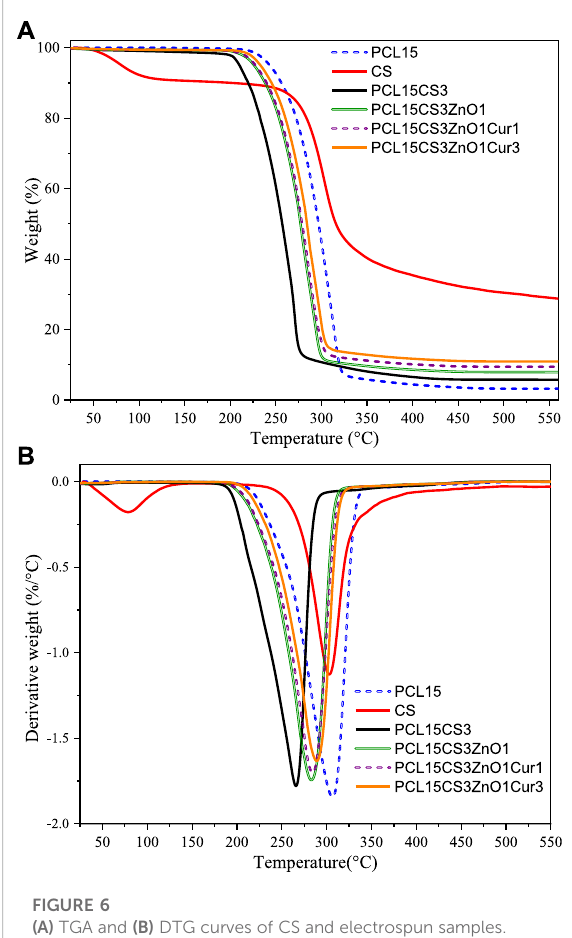
FIGURE 6 (A) TGA and (B) DTG curves of CS and electrospun